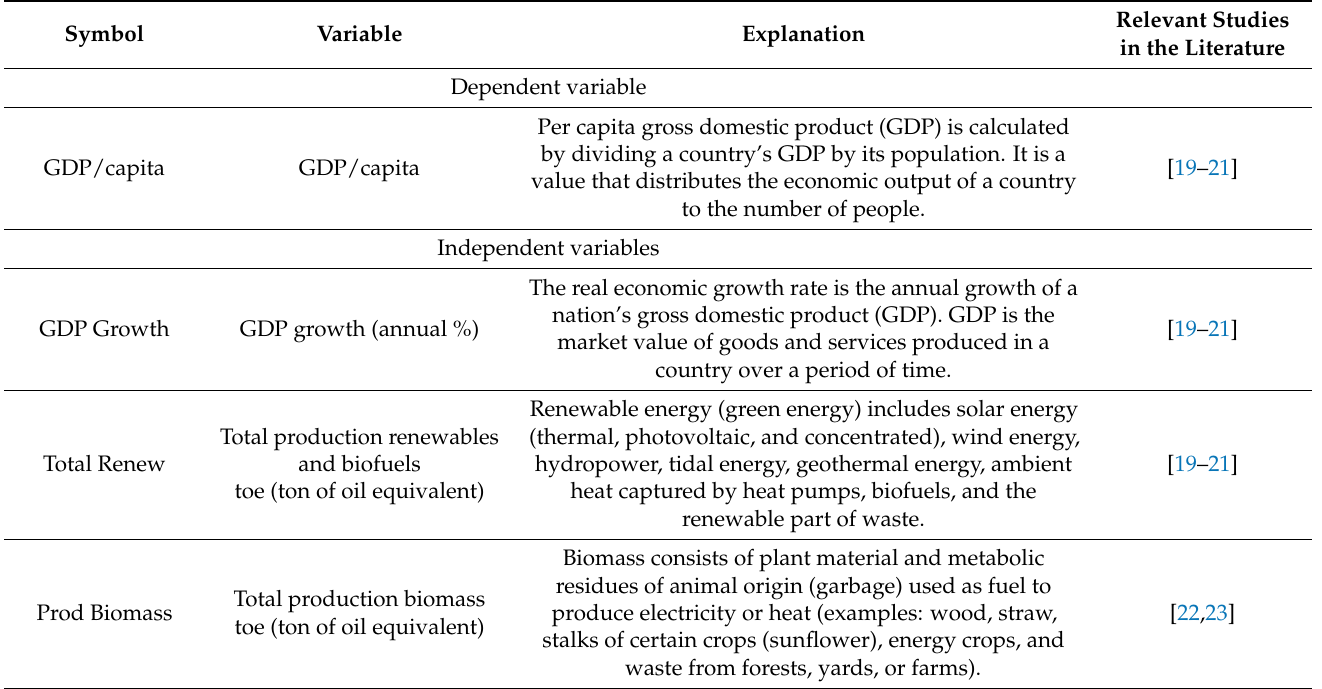
Table 1. Dependent and independent